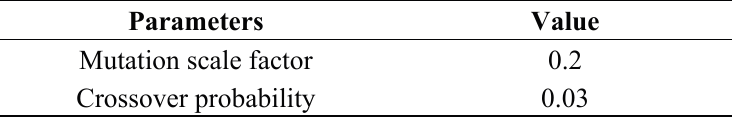
Table 7. The parameters setting of difference evolution (DE).